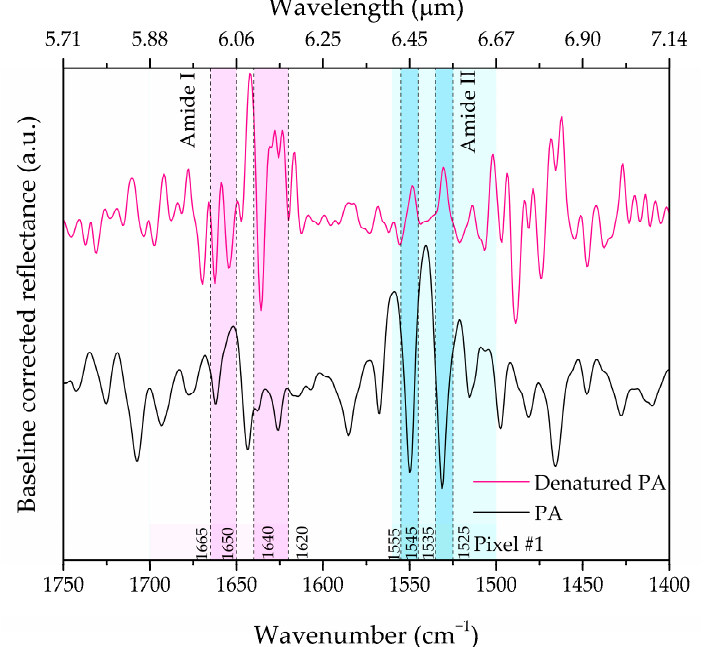
Figure 9. Pixel #1 baseline-corrected reflectance SEIRA spectrum of a dehydrated monolayer of PA (black curve) and of the denatured state (purple curve) after the immersion in HCl at 0.1 M with a PH = 1. Note the shift of the bands pertaining to Amide I (pink area) and Amide II (green area). The spectral region around 1665–1650 cm − 1 pertains to the helical structure Amide I vibration, while the one around 1640–1620 cm − 1 pertains to σ‐ sheet. The spectral region around 1555–1545 cm − 1 pertains to the helical structure Amide II vibration, while the one around 1535–1525 cm − 1 pertains to β‐ sheets.